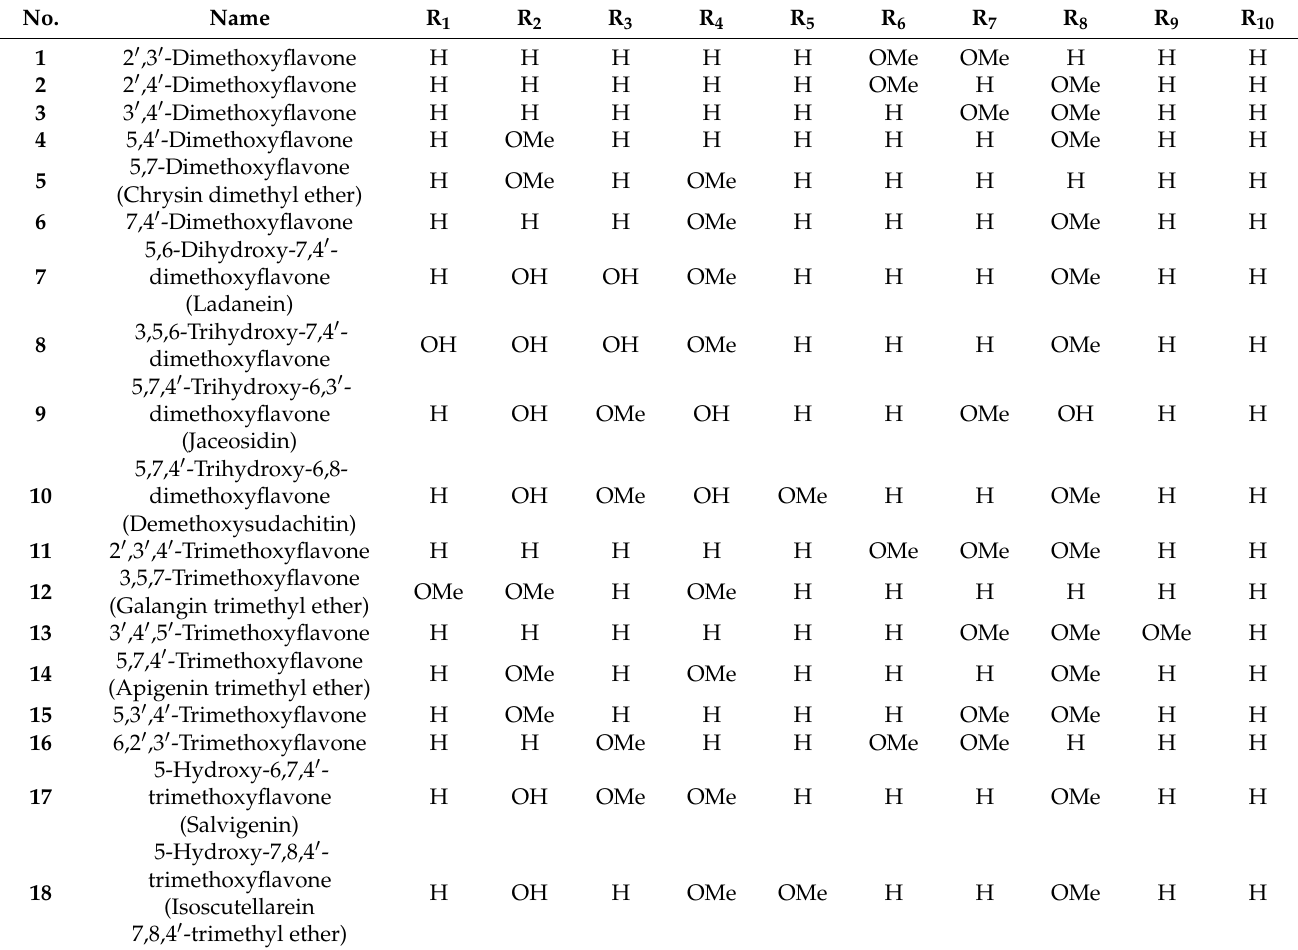
Table 13. 1 H-NMR and 13 C-NMR of polymethoxyflavanones’ ( 72 – 77 ) skeleton isolated in Citrus genus.